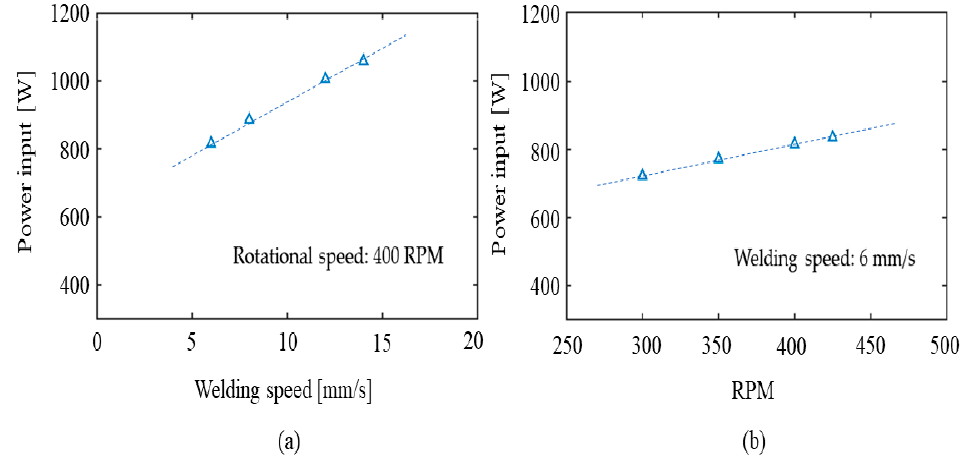
Figure 10. Sensitive analyses showing how the net power input responds to variations in the operational conditions; ( a ) Effect of welding speed on q 0 at a constant pin rotational speed of 400 RPM, ( b ) Effect of the pin rotational speed on q 0 at a constant welding speed of 6 mm/s.